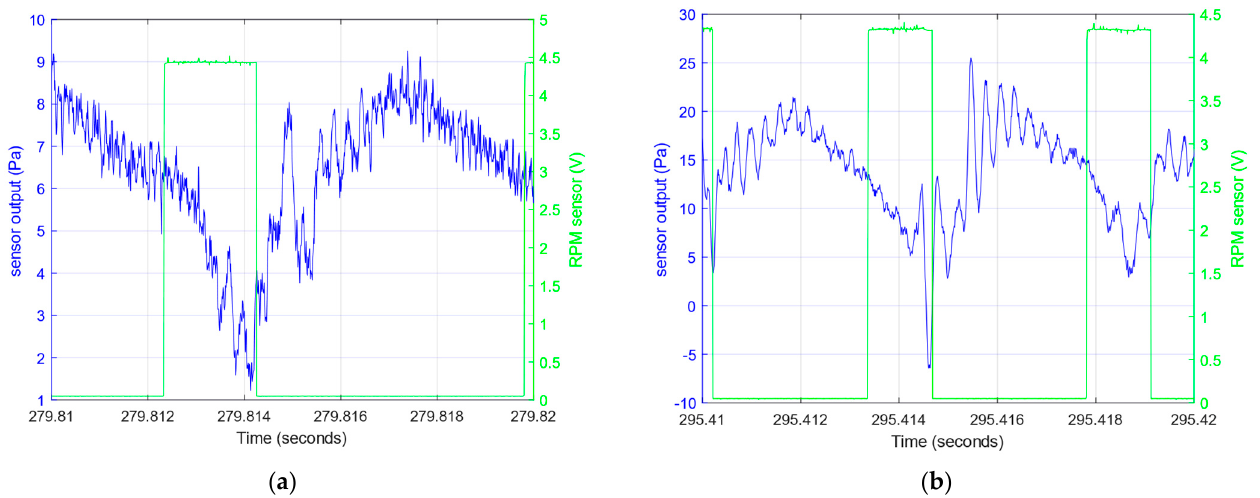
Figure 12. Samples of the recorded 10 ms of pressure responses (4019 ( a ) and 6750 ( b ) RPM) (blue) and pulses of the laser RPM meter (green).